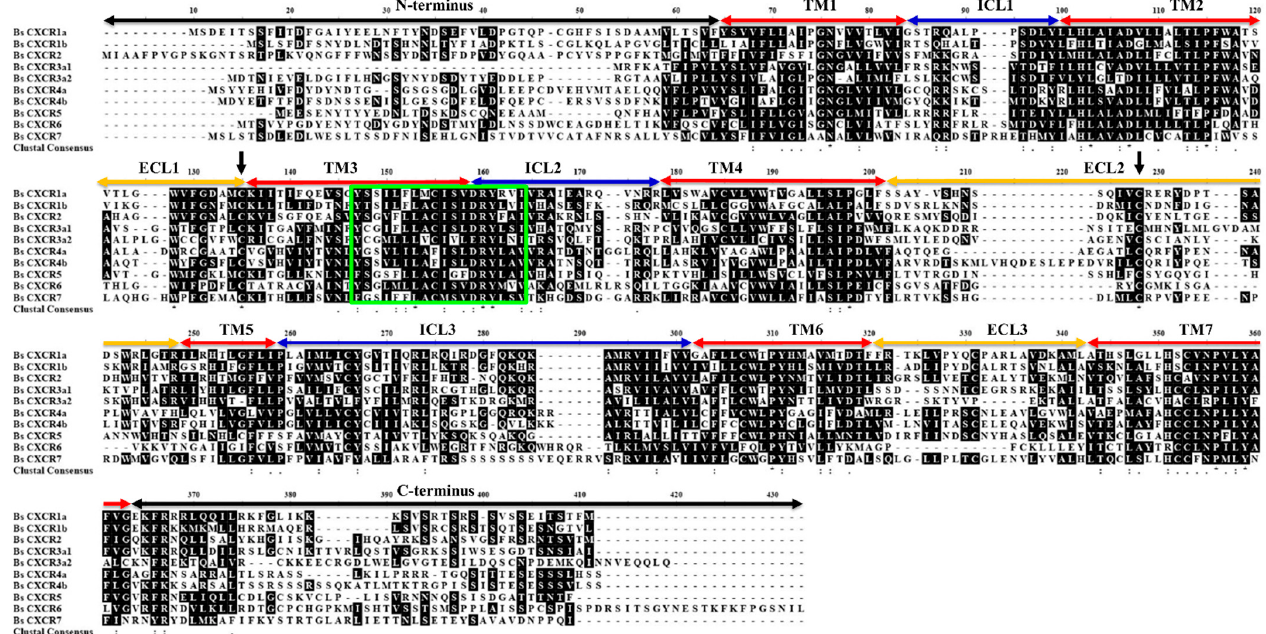
Figure 4. Multiple amino acid sequence alignment of BsCXCR1-7 proteins. TM, transmembrane domain; ECL, extracellular loops; ICL, intracellular loops. Black arrows indicate the conserved cysteine residues. The signature region is shown in the box.